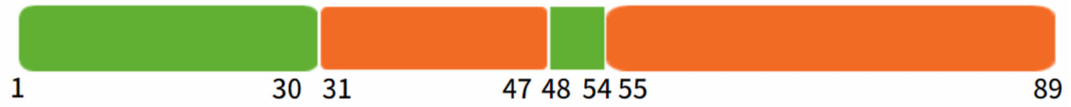
Figure 8. The prediction result of IAPP based on our system.